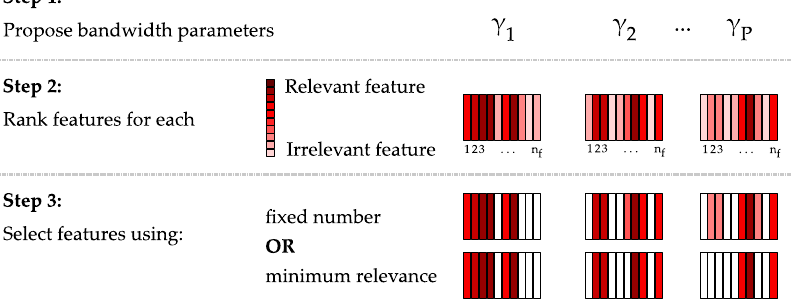
Figure 2. A graphical illustration indicating how the automatic feature grouping strategy works. Step 1 consists of proposing a number of bandwidth parameters for the RBF kernel; in Step 2, a feature ranking is done using backwards-elimination and a kernel-class separability measure with the assigned γ to determine the relative relevance of each n f features; in Step 3, a feature set is selected for each kernel based on (i) using a fixed number of features per kernel, e.g., six in the illustrated example; or (ii) a minimum cumulative feature relevance level, which may result in different numbers of features per kernel.